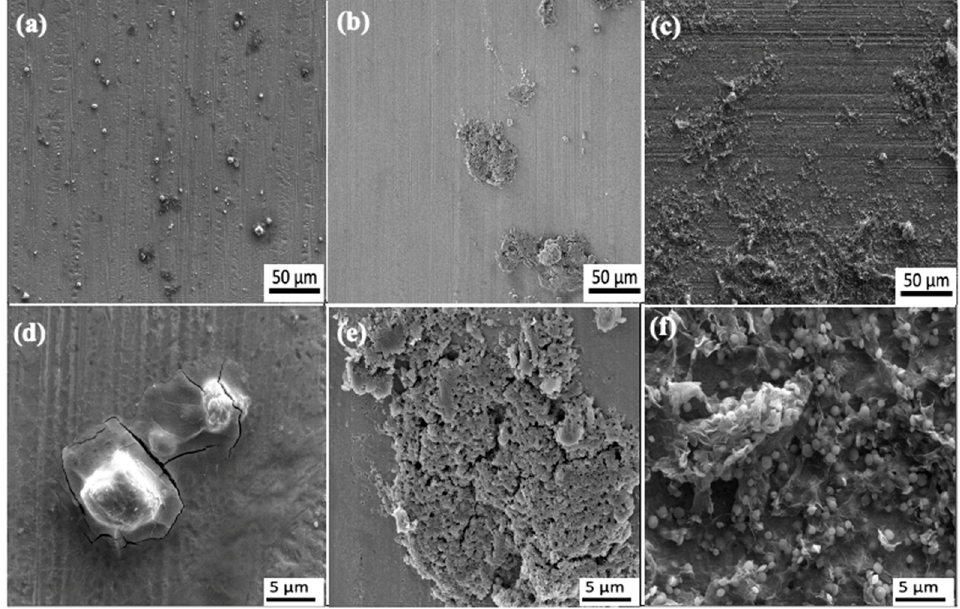
Figure 2. SEM morphology of the Gnps, ( a – c ): low magnification, ( d – f ) high magnification, ( a , d ) C750 Gnp, ( b , e ) M15 Gnp, ( c , f ) X50 Gnp.